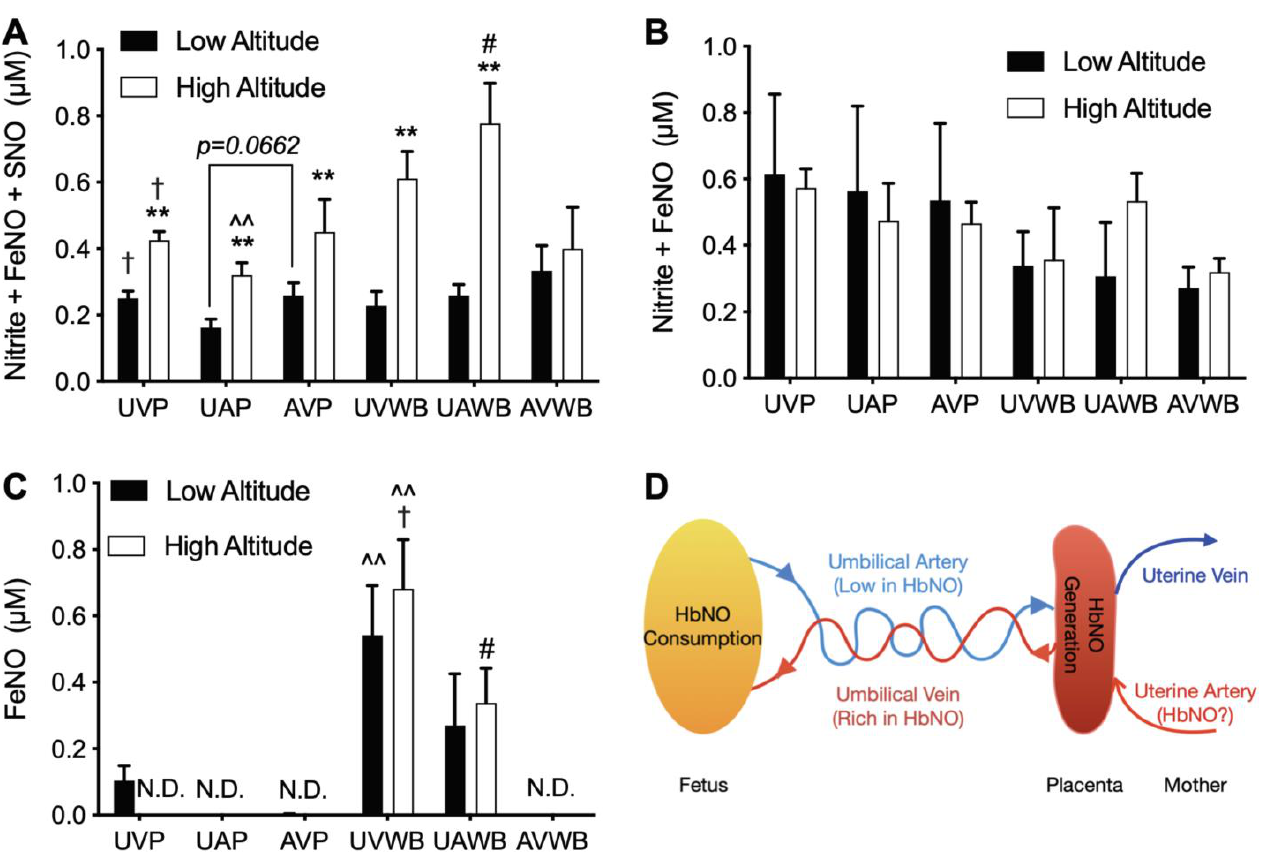
Figure 4. NOx levels in blood from high and low altitude pregnant sheep. NOx were measured by chemiluminescence NO analyzer with various purge vessel reagents. ( A ) I 3 (measures nitrite, FeNOs, and SNOs). ( B ) FeCN/HAc (nitrite and FeNOs). ( C ) FeCN/PBS (FeNOs). ( D ) Proposed diagram for dynamic homeostasis of HbNO in gestation. UVP: umbilical vein plasma; UAP: umbilical artery plasma; AVP: adult vein plasma; WB: whole blood. N.D.: not detectable. Two-way ANOVA with Tukey’s post-hoc tests for plasma or WB. * = p < 0.05 high vs. low altitude; # = p < 0.05 fetus (UA) vs. mother (AV); † = p < 0.05 umbilical artery vs. vein; ^ = p < 0.05 plasma vs. WB. p value for paired t test in ( A ). One symbol = p < 0.05, two symbols = p < 0.01.